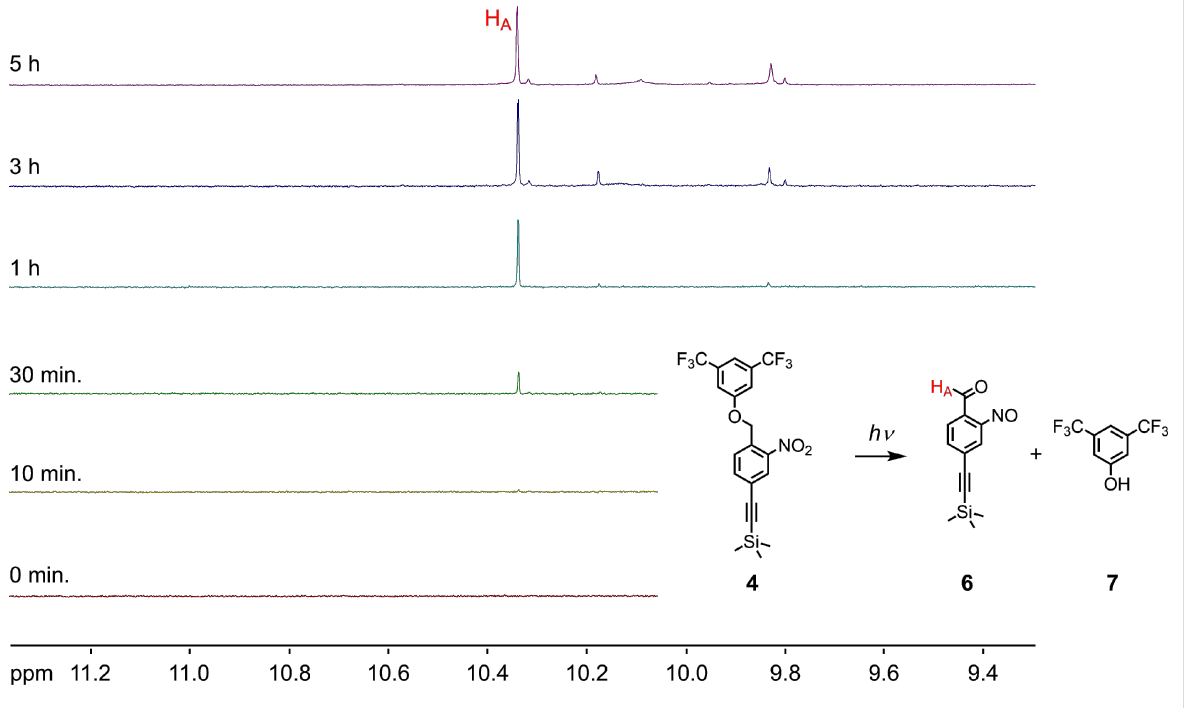
Photoresponse of neutral model compounds in high